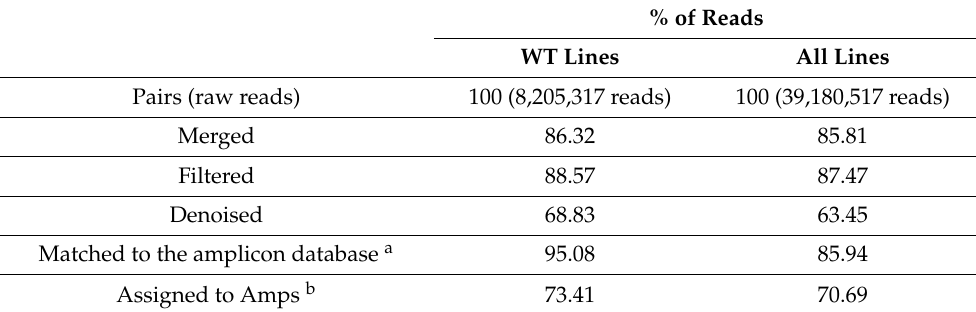
Table 2. Percentage of reads which exceeded at each step of the optimized Usearch pipeline following the protocol with all WT lines raw dataset (left) and all lines, including WT and CRISPR lines, raw dataset